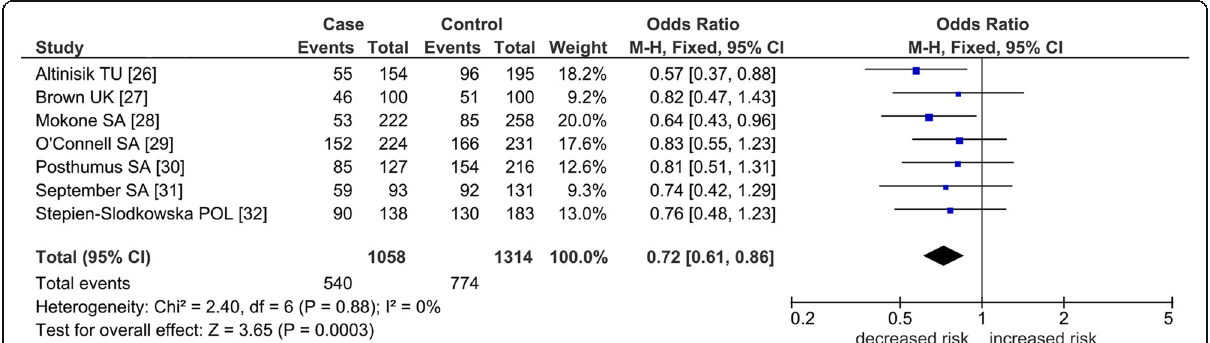
Fig. 4 Post-outlier association of COL5A1 rs12722 polymorphism with TLI studies in the dominant model. Numbers in brackets under the study column indicate references. Squares indicate the odds ratio (OR) in each study, with square sizes directly proportional to the weight contribution (%) of the study. Horizontal lines on each side of the squares represent 95% confidence intervals (CIs). The fixed-effects model was used on account of zero heterogeneity ( p = 0.88, I 2 = 0%). M – H Mantel – Haenszel; df degree of freedom; TU, Turkey; UK, United Kingdom; SA, South Africa;